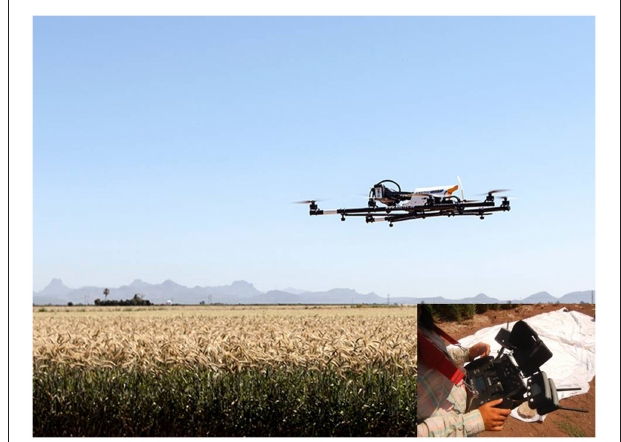
FIGURE 1 | The airborne remote sensing platform used in this study: The AscTec Falcon 8 Unmanned Aerial Vehicle (UAV), operated with the Mobile Ground Station